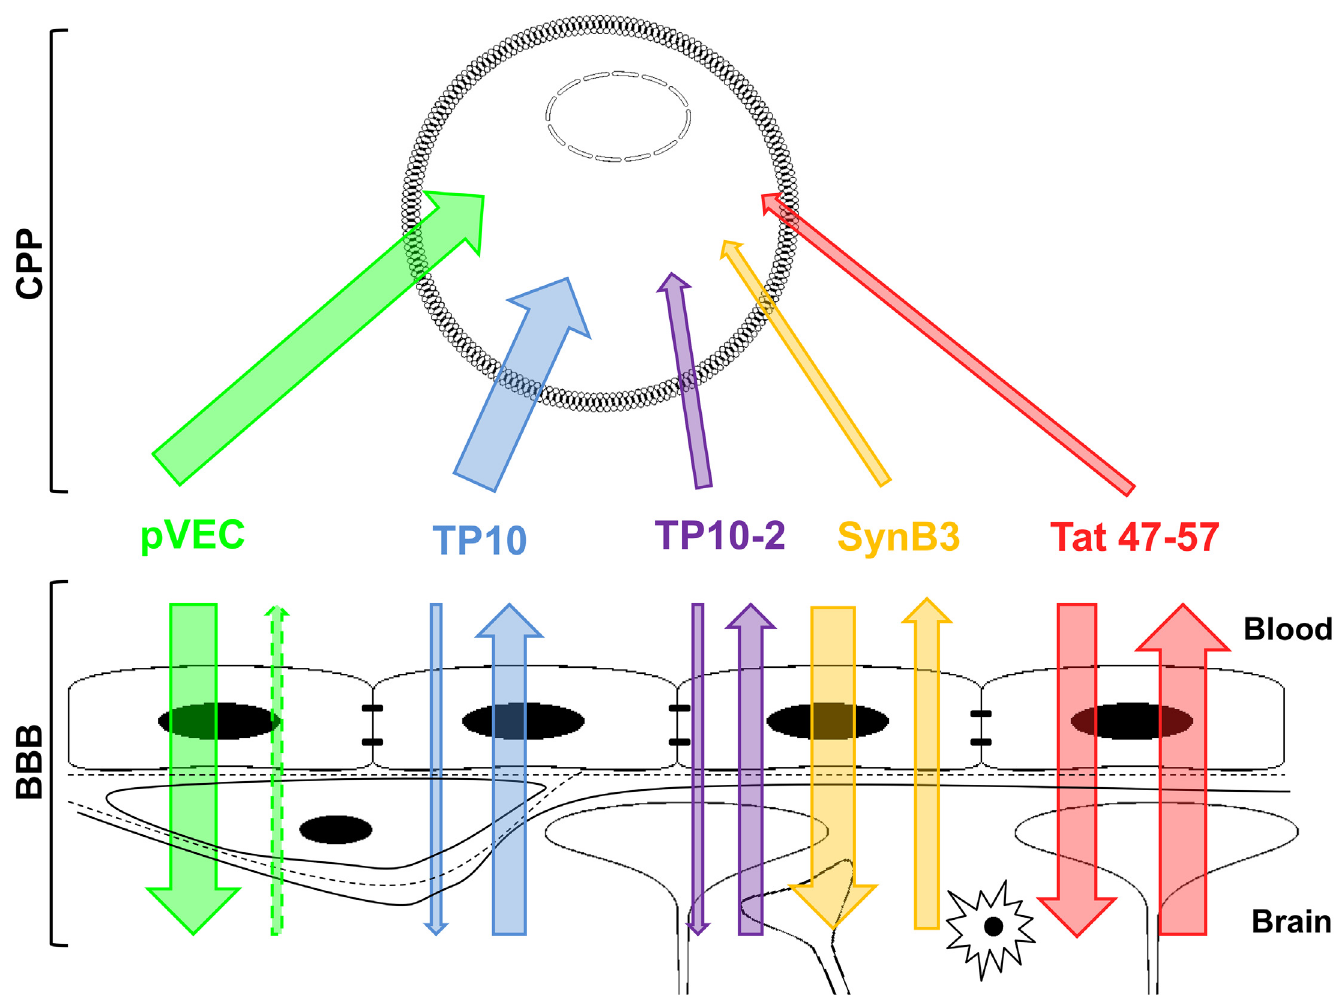
Fig 6. Schematic overview of the relationship between cell-penetrating and BBB-penetrating properties of the five investigated CPPs. The thickness of the arrows indicates the extent of influx and/or